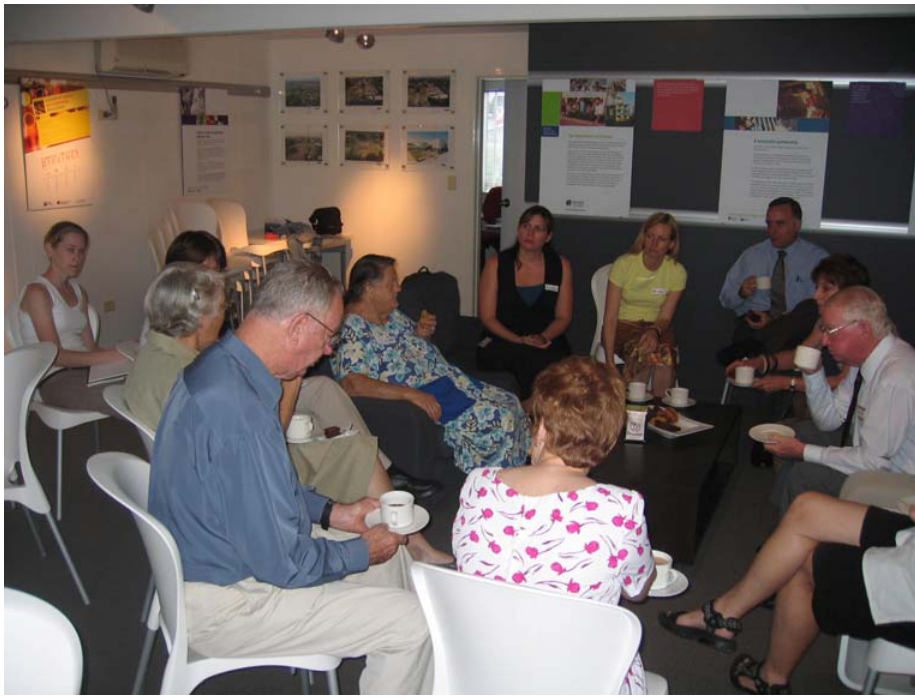
Figure 14: KGUV Sharing Stories Workshop